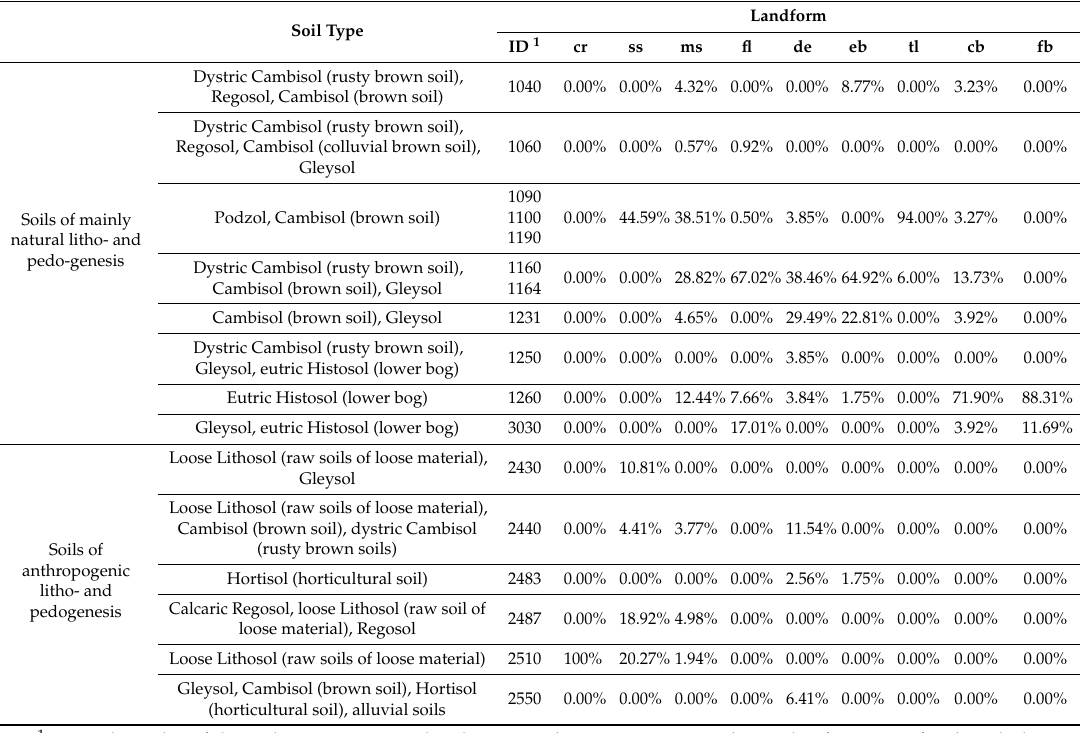
Table 6. Correlation of landforms classification results based on the LiDAR-DEM and soil types according to the digital soil map 1:50,000 for study area